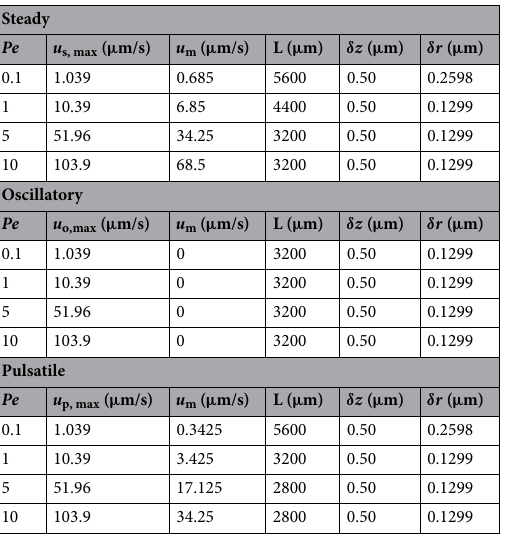
Table 1. Parameter values for the bolus simulations. The domain length L was adjusted to ensure near- zero concentration at the inlet and outlet. In the cases of steady and pulsatile flows, this was done such that concentration near the boundaries remained near zero at least until the peak concentration was translated a distance of 300 µ m. As such, the domains of lower Pe flows were longer to minimize diffusive transport to the boundaries, which could lead to misleading results. Grid sizes δ z and δ r (in the axial and radial directions, respectively) were adjusted to ensure stability and convergence. u m is the mean velocity, averaged over both space and